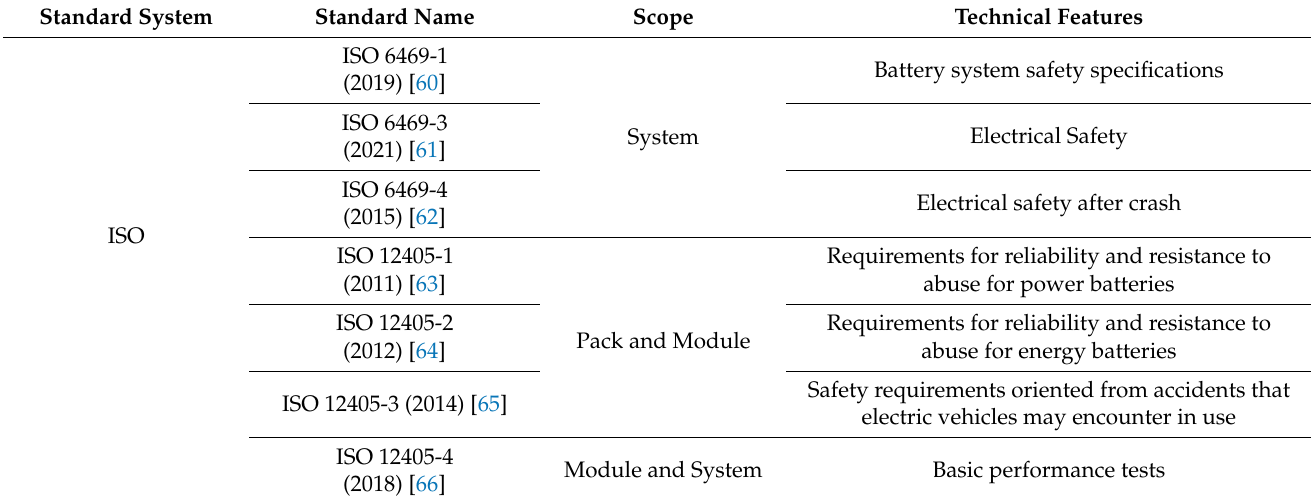
Table 1. Applicable scope and characteristics of the general standards for